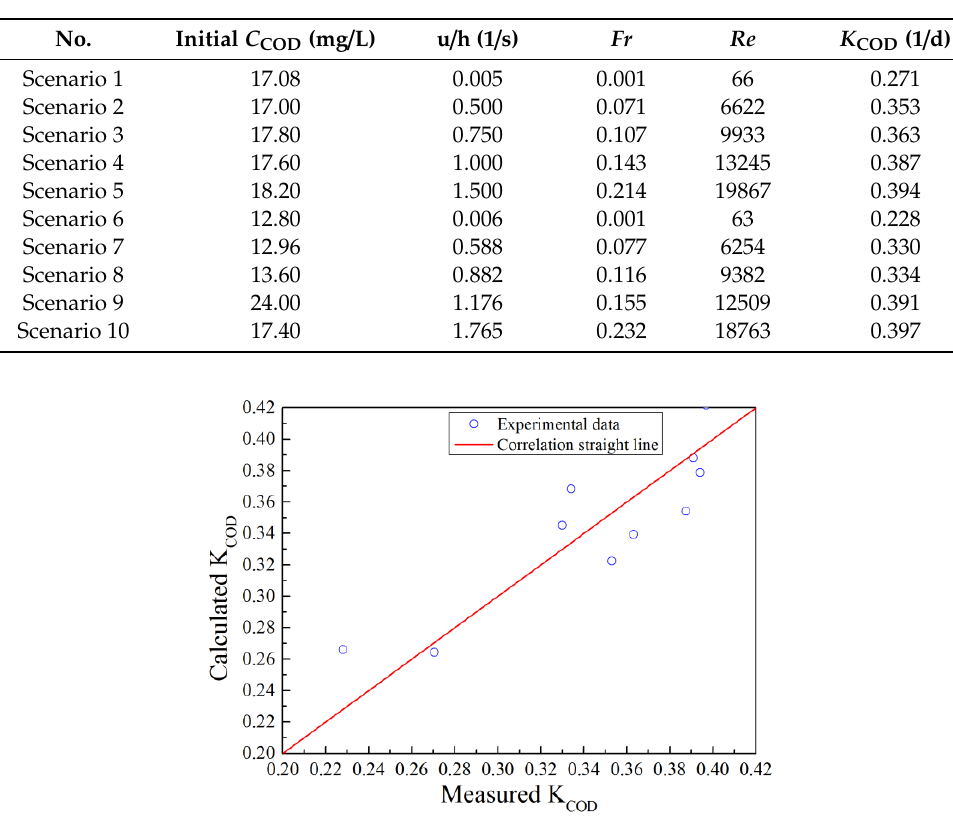
Table 3. Experimental data.